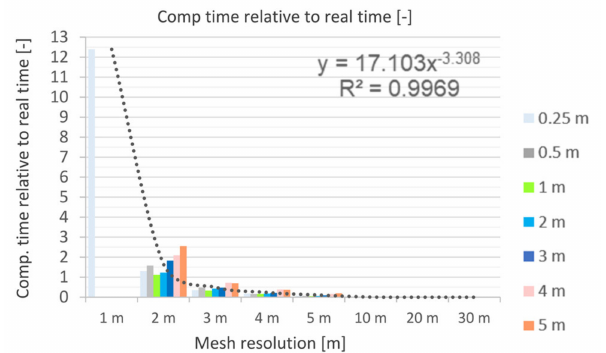
Figure 22. Overview of results of computational time CT for the different mesh and DEM resolutions (DEM: colored